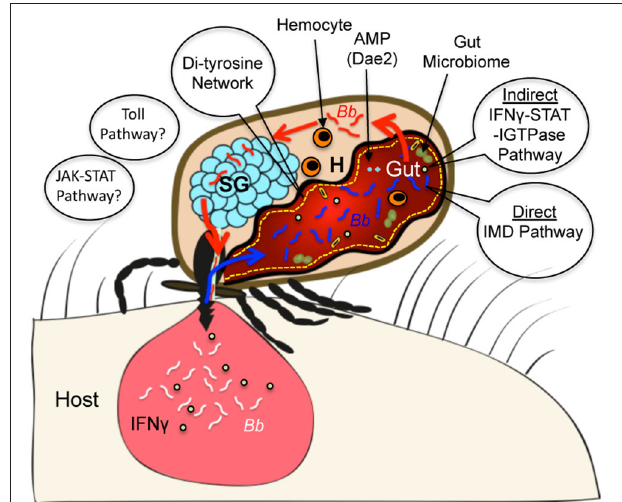
FIGURE 1 | Diagram highlighting representative examples of Ixodes immune components that impact persistence of Lyme disease agents. During tick engorgement on a mammalian host, B. burgdorferi ( Bb, white color) from an infected host dermis are acquired in ticks ( Bb in tick gut indicated in blue color). Ixodes ticks can recognize the presence of pathogens in the incoming blood using multiple immune surveillance mechanisms, including an indirect cross-species signaling mechanism that involves sensing mammalian cytokines like IFN γ (indicated by green dots). Ingested cytokine in the tick initiate microbicidal responses involving a tick STAT, an immune GTPase (IGTPase) and an antimicrobial protein (AMP) like Dae2. In addition, a direct recognition mechanism, such as involving an atypical IMD pathway, is also operative in ticks that limits spirochete levels in the vector. The other classical components of innate immune cascades like Toll and JAK-STAT signaling pathways, which are although represented in Ixodes genome, their roles in direct recognition of B. burgdorferi in Ixodes ticks remain unknown. Additional factors in the gut, such as a feeding induced molecular barrier (di-tyrosine network) and the gut microbiome also impact the persistence of spirochetes. During a subsequent blood meal, Bb (red color) exit the tick gut and disseminate to salivary gland (SG) via hemocoel (H), which contains hemocytes that can also impact microbial survival in the